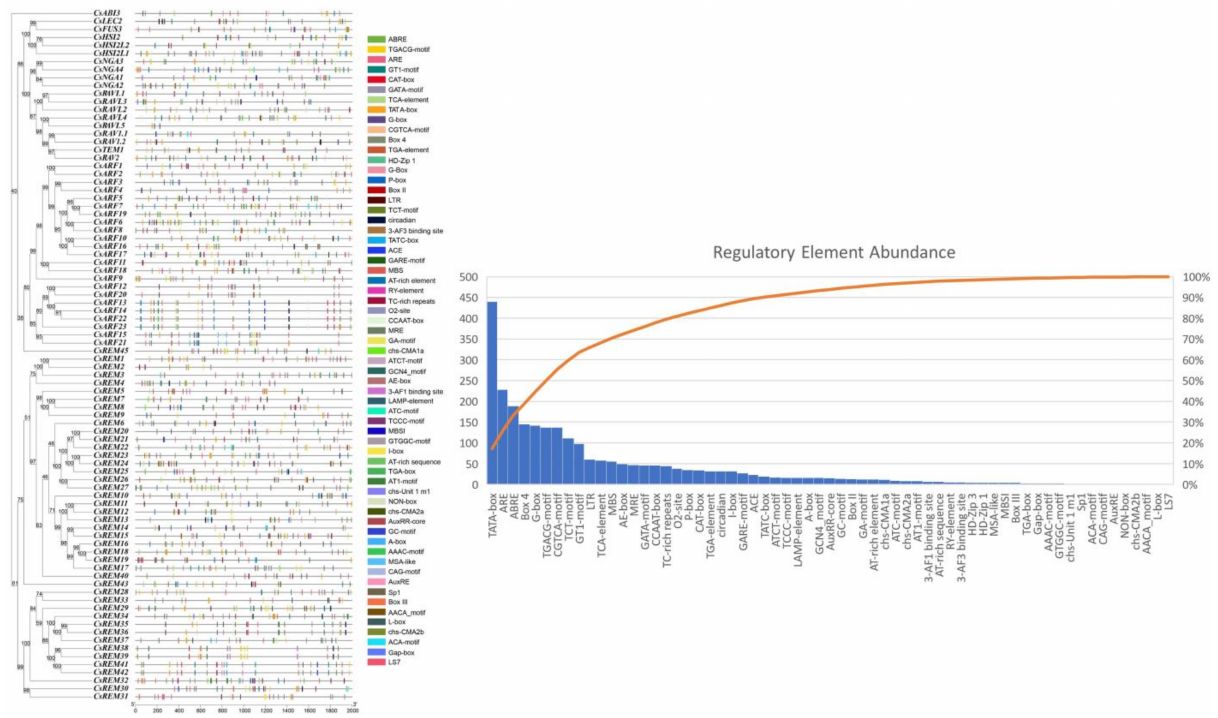
Figure 3. On the left panel are the results for the cis-acting regulatory element analysis of B3 genes in C. sativa , and on the right panel is the graph for the most abundant cis-acting